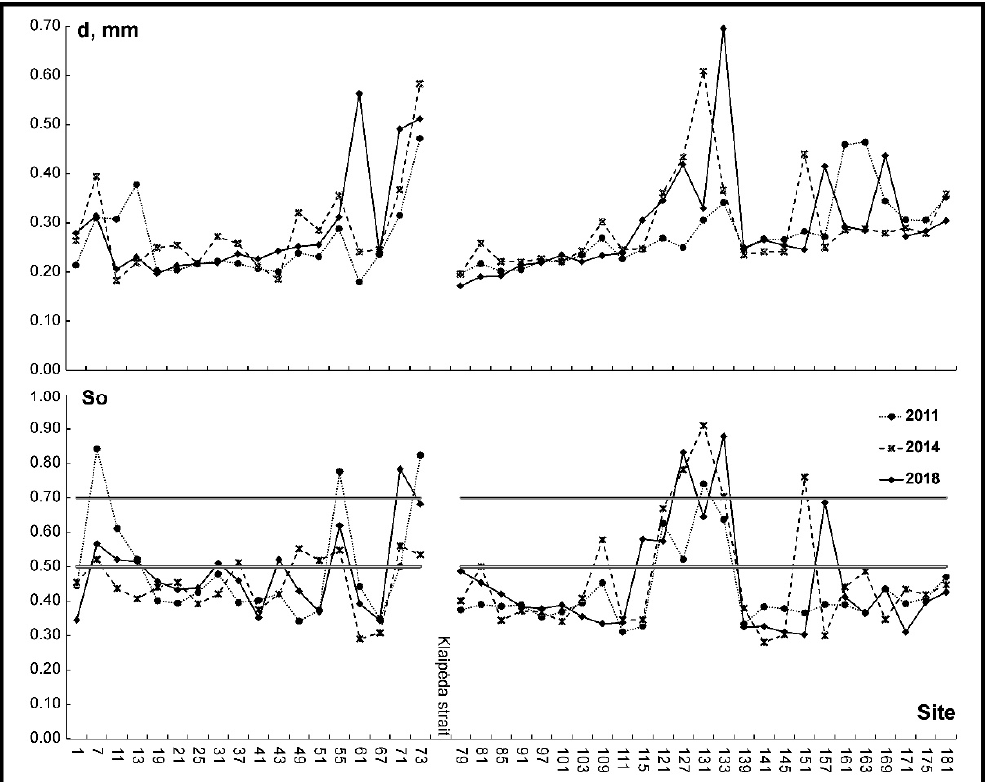
Figure 2. The distribution of grain-size (d, mm) and sorting ( S o ) of the beach sediments along the coast of the south-eastern Baltic Sea coast (Lithuania) in 2011, 2014, and 2018.